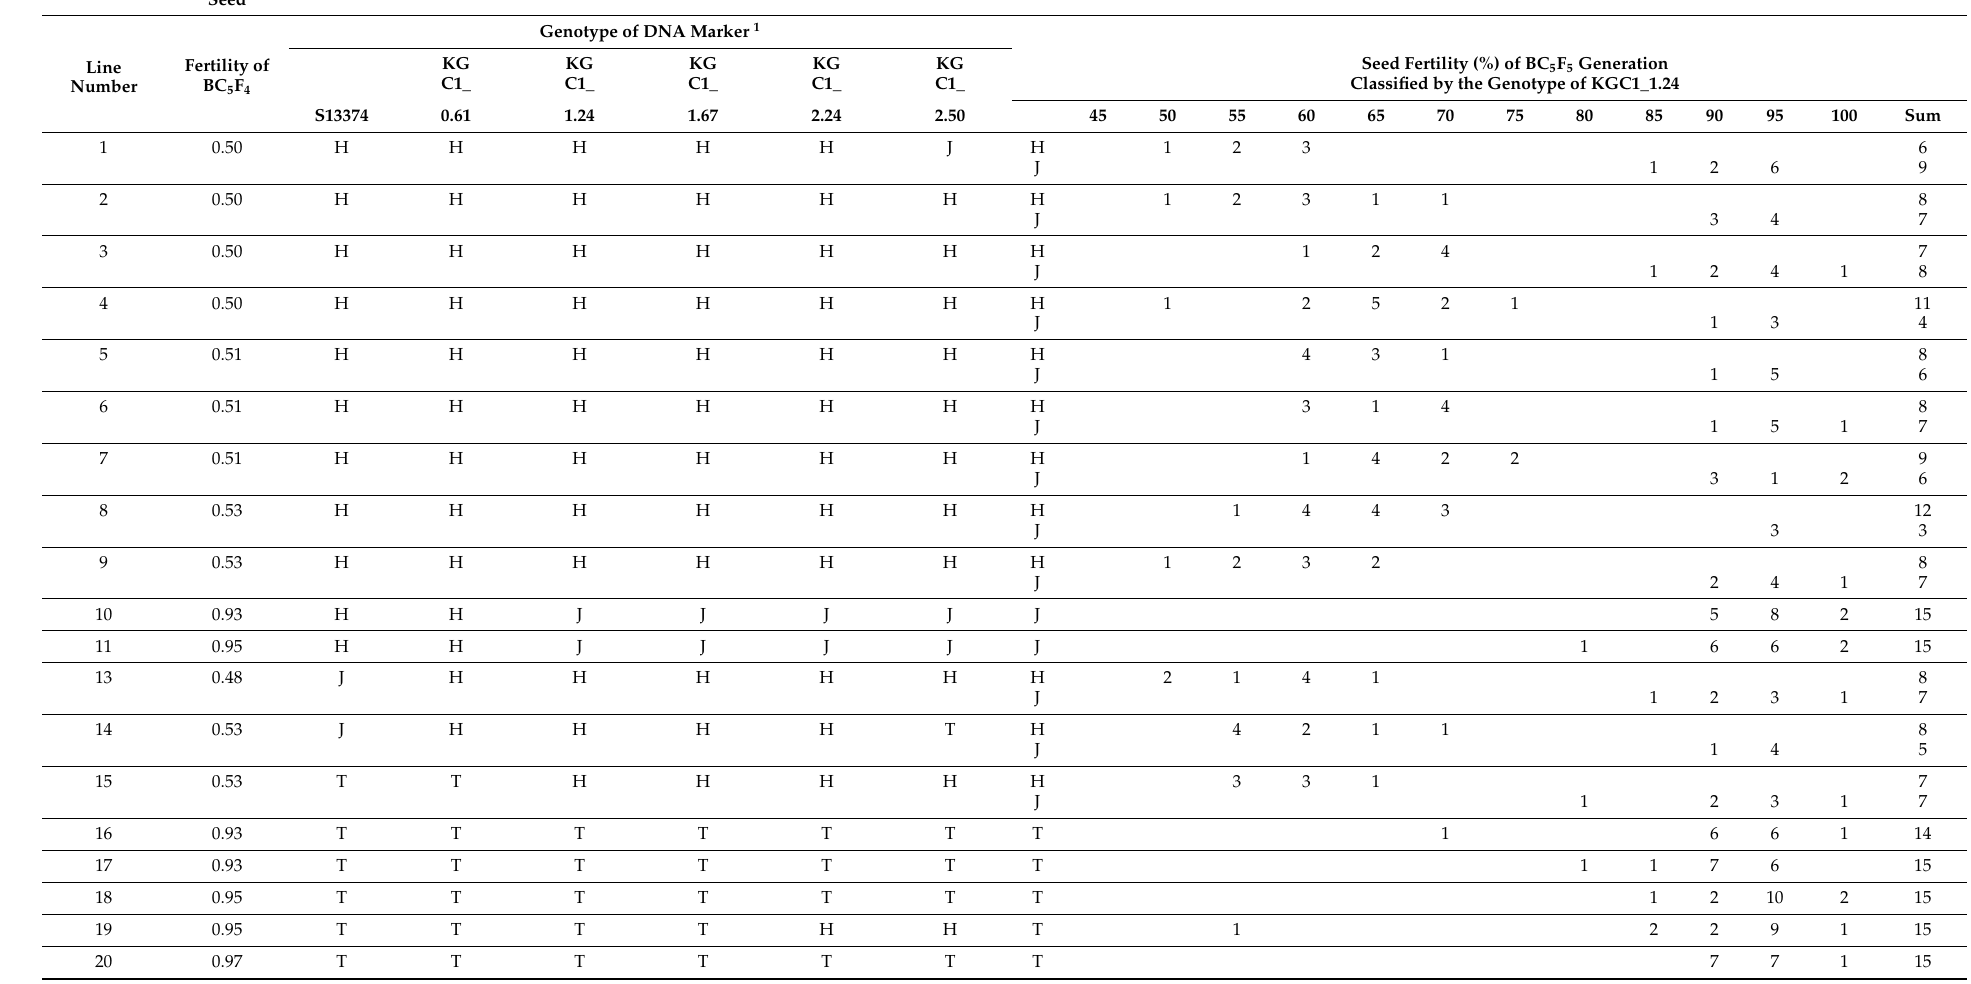
Table 3. Genotypes of selected BC 5 F 4 and seed fertility of BC 5 F 5 generation classified by